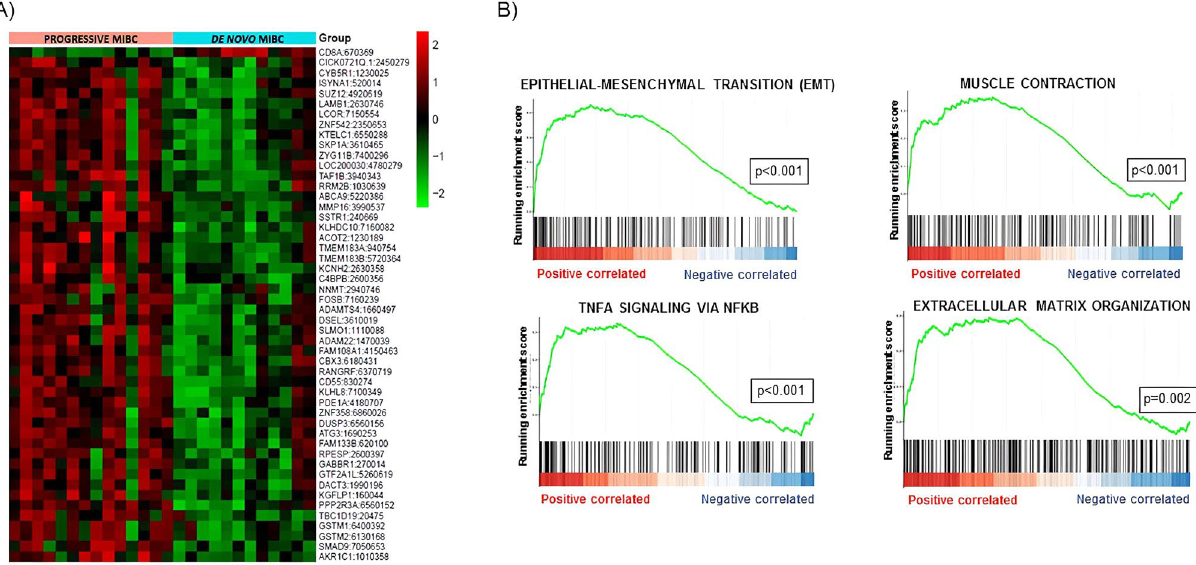
Figure 2. Gene expression profiles in progressive and de novo MIBC samples. ( A ) Heat map displaying the 50 most differently expressed genes between progressive and de novo MIBC samples. Red pixels correspond to an increased abundance of mRNA in the samples, whereas green pixels indicate decreased mRNA levels. Rows represent genes and columns represent experimental samples. ( B ) Gene set enrichment analysis (GSEA) shows positive correlation of overexpressed genes in pathways involved in tumor progression.